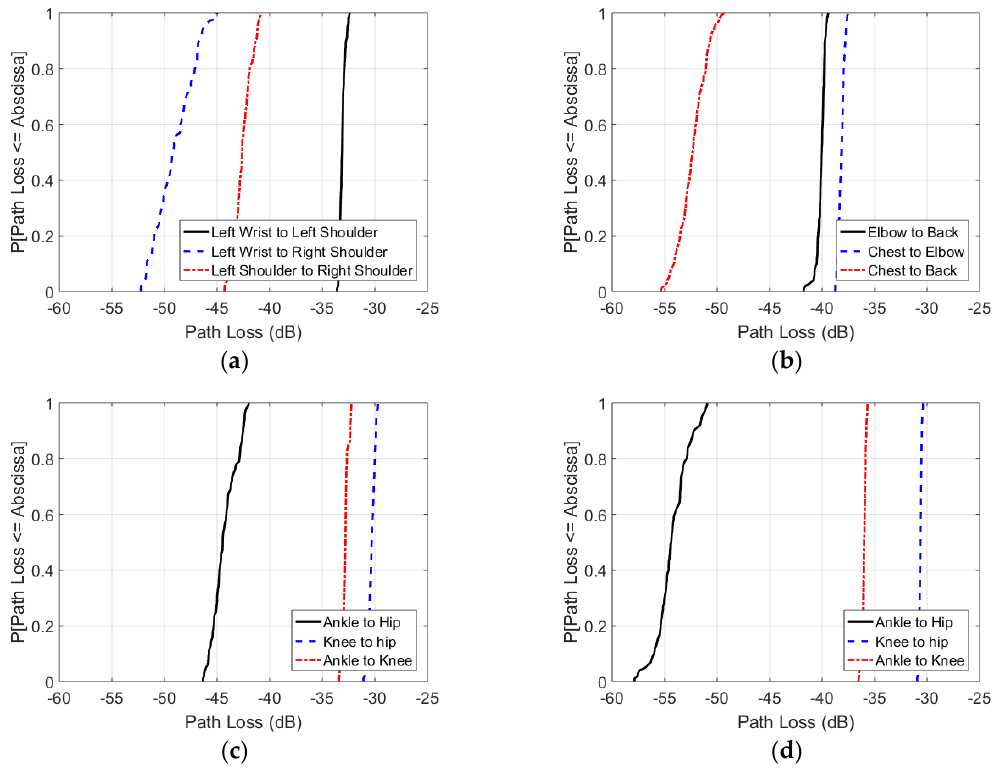
Figure 13. Cumulative distribution function of on-body path loss in between monopole antennas at 2 GHz in four on-body scenarios: ( a ) Standing upright with monopole antennas on the left wrist, left shoulder, and right shoulder; ( b ) Standing upright with monopole antennas on the chest (sternum), left elbow, and back (in between the shoulder blades); ( c ) Standing upright with monopole antennas on the ankle, knee, and hip; ( d ) Sitting with monopole antennas on the ankle, knee, and hip.